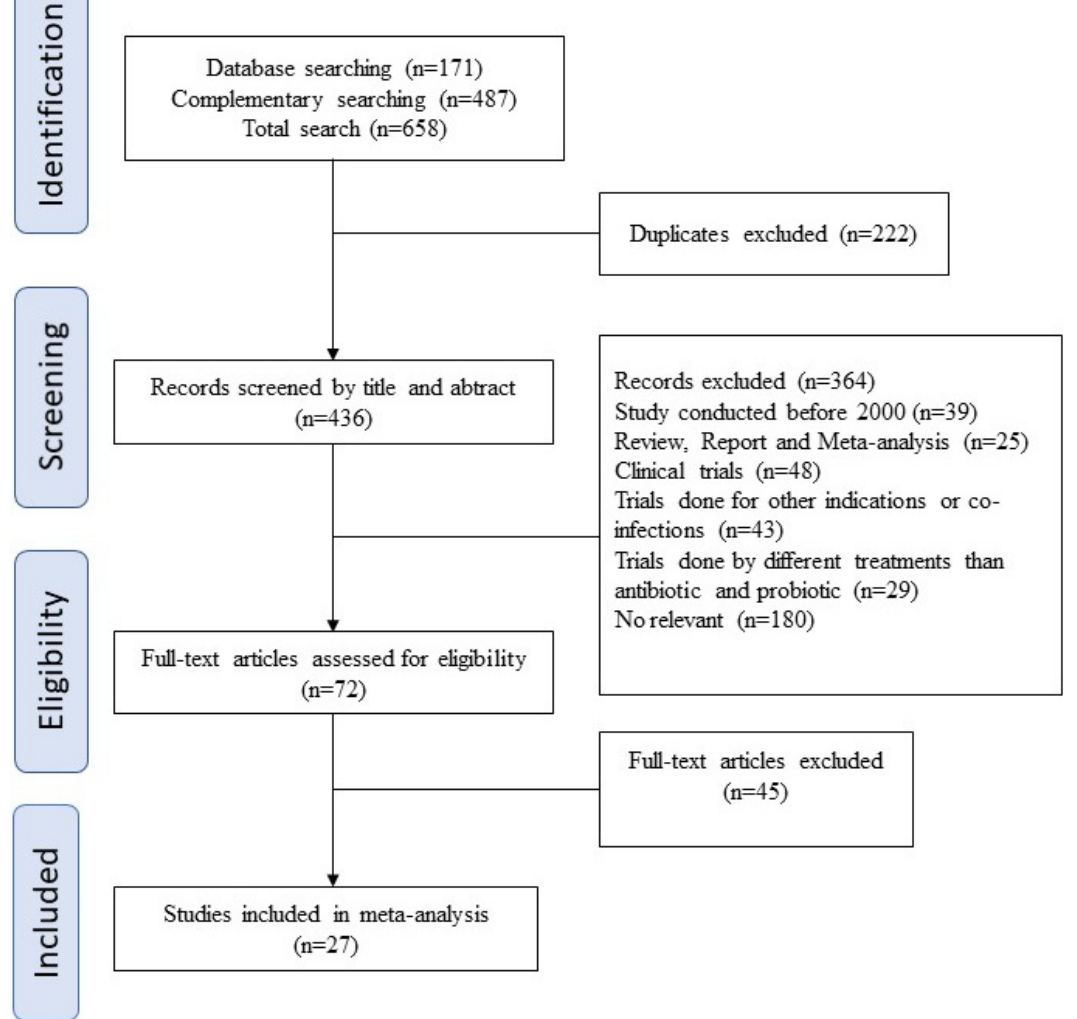
Figure 1. Prisma flow chart of the eligible studies obtained during the screening process. Table 1. General information extracted from the data set and selected for the present